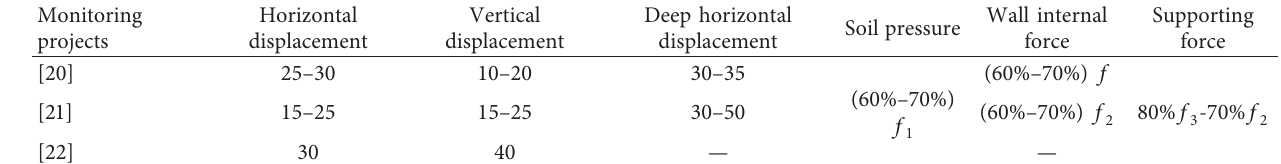
Table 1: Early warning value (mm)